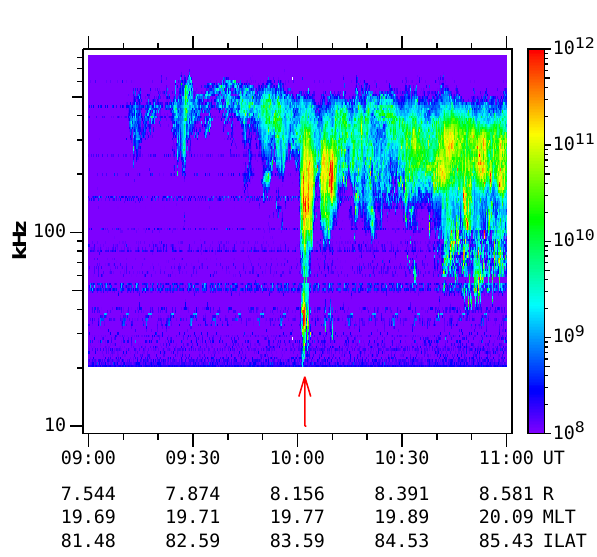
Fig. 3. Example of the radiospectrogram (in units of Jansky) of a dot-AKR event obtained on 14 December 1996 with the Plasma Wave Instrument (PWI) on Polar. The dot-AKR (red arrow) is seen near 10:00 UT at frequencies of 25–55kHz.